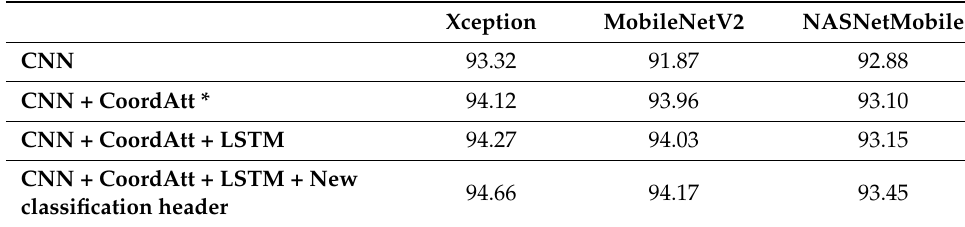
Table 3. The first set of ablation experiments, evaluation metric: Accuracy (%). Xception MobileNetV2